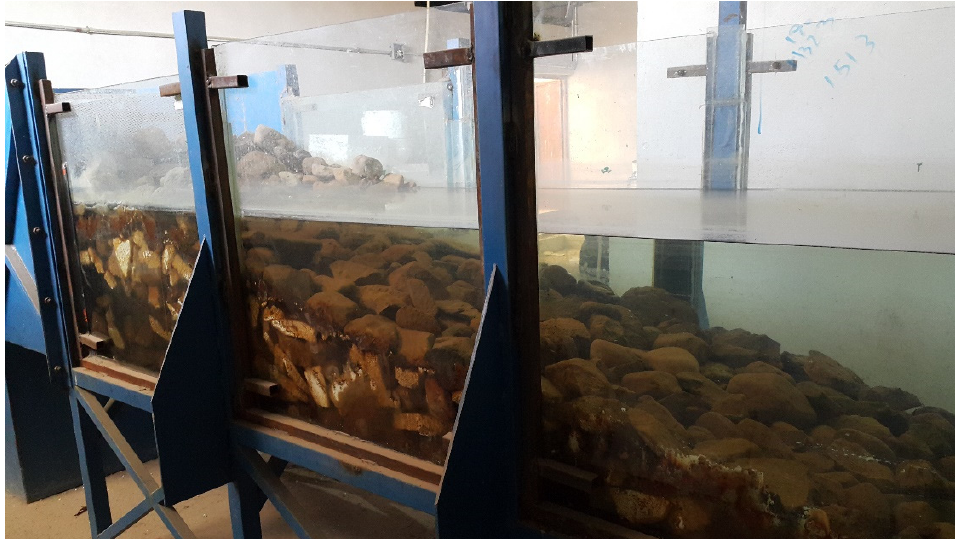
Figure 4. The stone beach at the end of the tank.